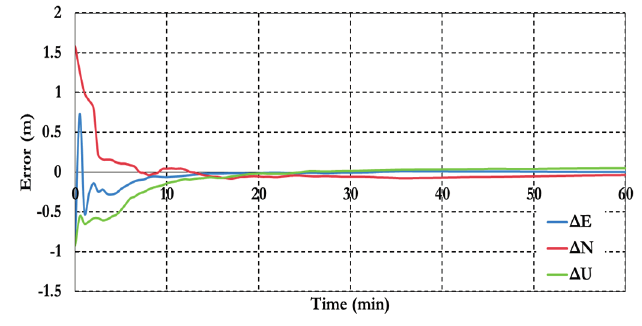
Figure 12. Positioning results of the semi-decoupled clock PPP model.